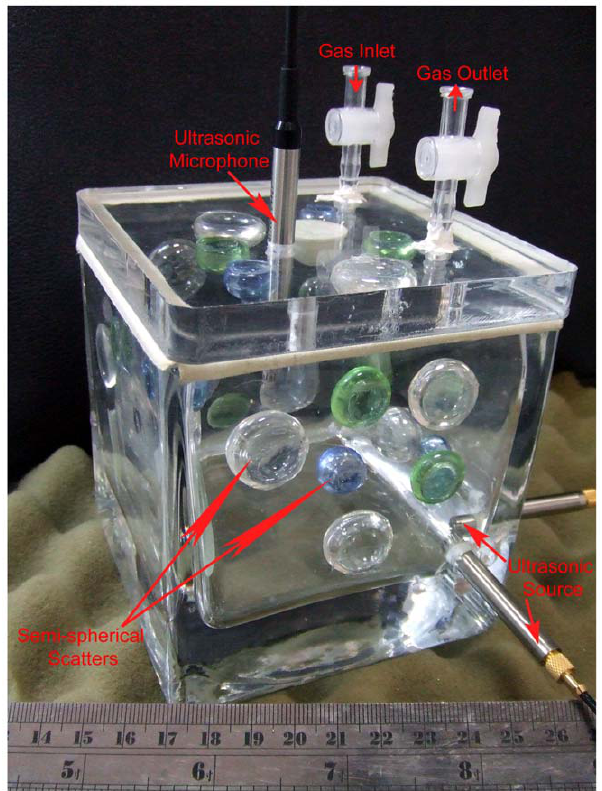
Figure 4. Reverberation chamber used for the ultrasonic absorption measurements. The ultrasonic source is deployed in a chamber corner, and the ultrasonic microphone can be moved from the lid up-and-down to warrant spatial averages. Many semi-spherical scatters are also deployed on the interior surfaces to achieve a diffuse sound field within the frequency range of interest. Medium exchange by nitrogen is carried out by one of the gas inlet/outlets.